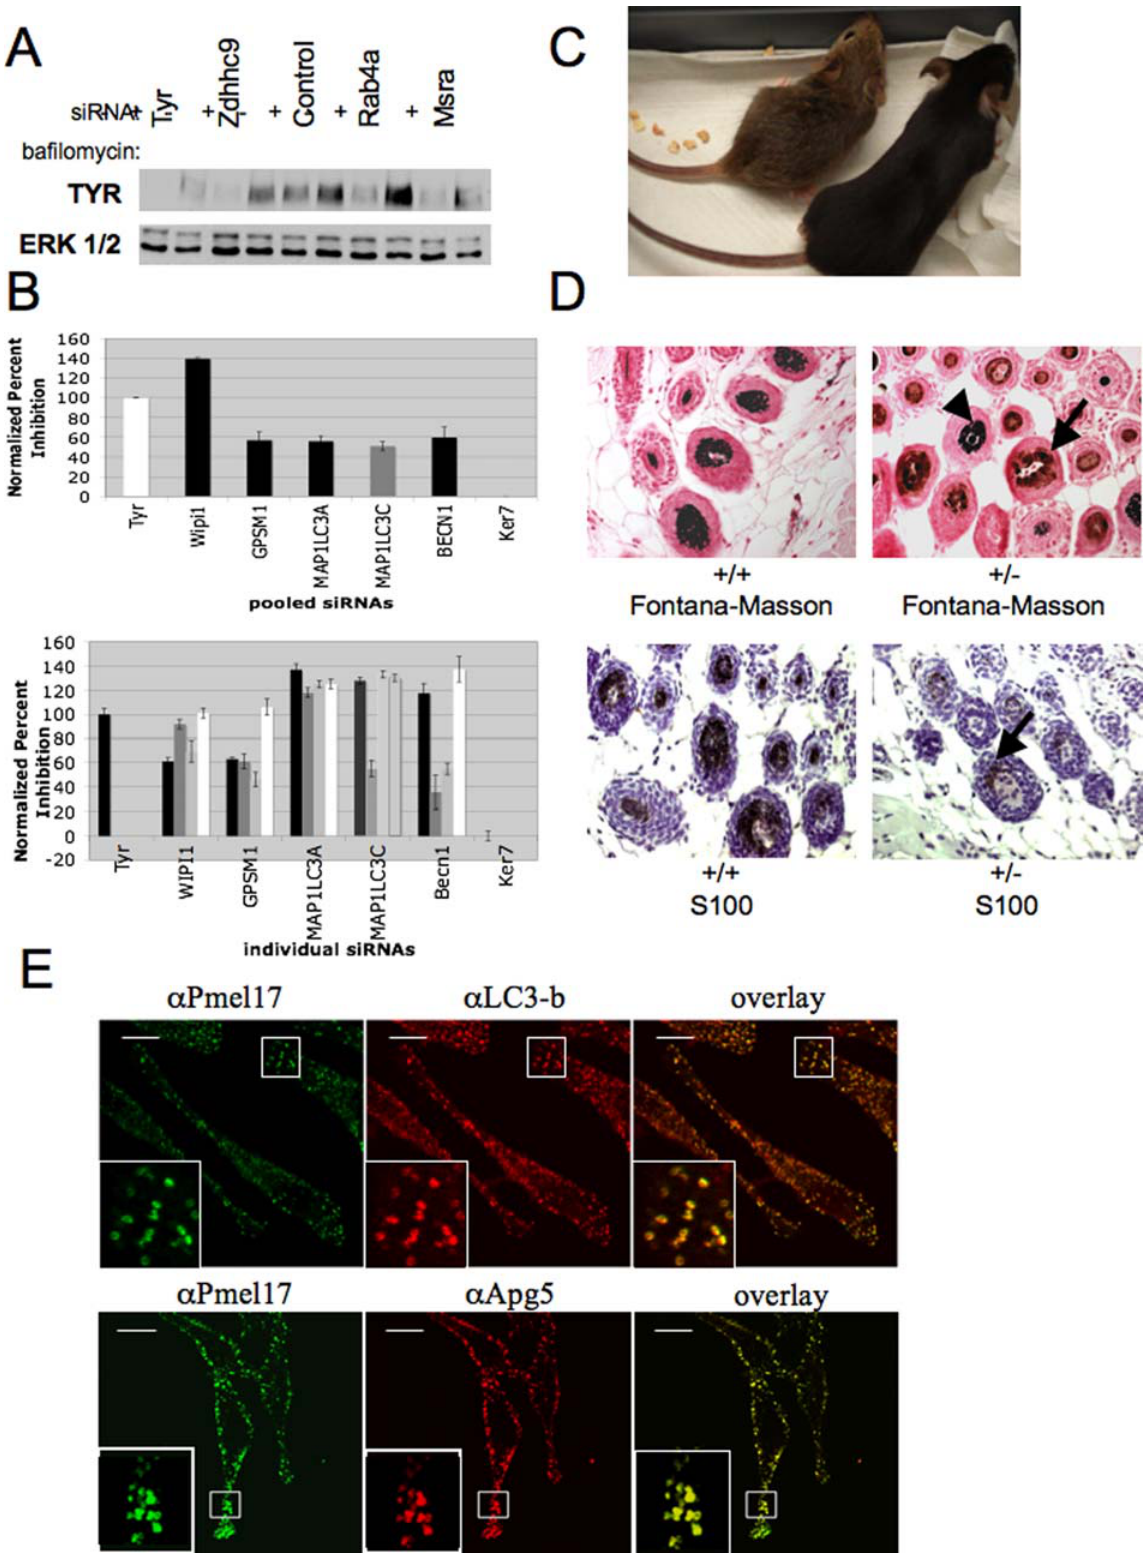
Figure 3. Autophagy is a novel biological process regulating melanin production. A) MNT-1 cells transfected with the indicated siRNAs (50 nM) were incubated in the presence and absence of bafilomycin A1 for 24 hours prior to lyses and analyses of tyrosinase protein accumulation. All results shown are representative of a minimum of three independent experiments. B) MNT-1 cells were transfected with the indicated siRNA pools (50 nM final concentration) or individual siRNAs (75 nM final concentration) targeting putative genes that regulate autophagy identified in the primary